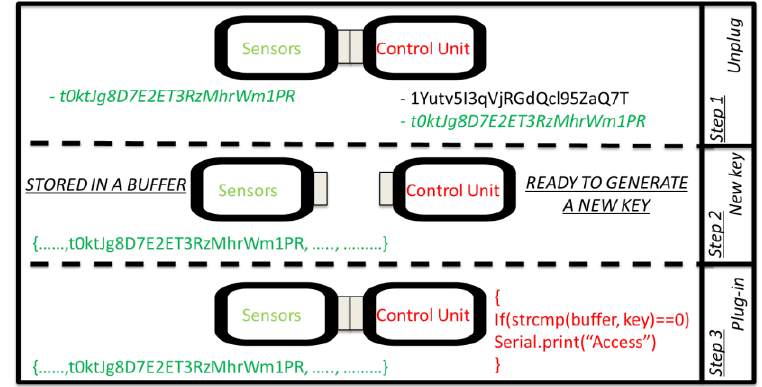
Figure 17. Control unit and sensor; communication module authentication process.